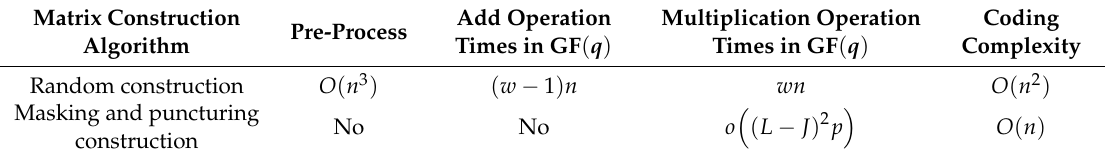
Table 1. Coding complexity